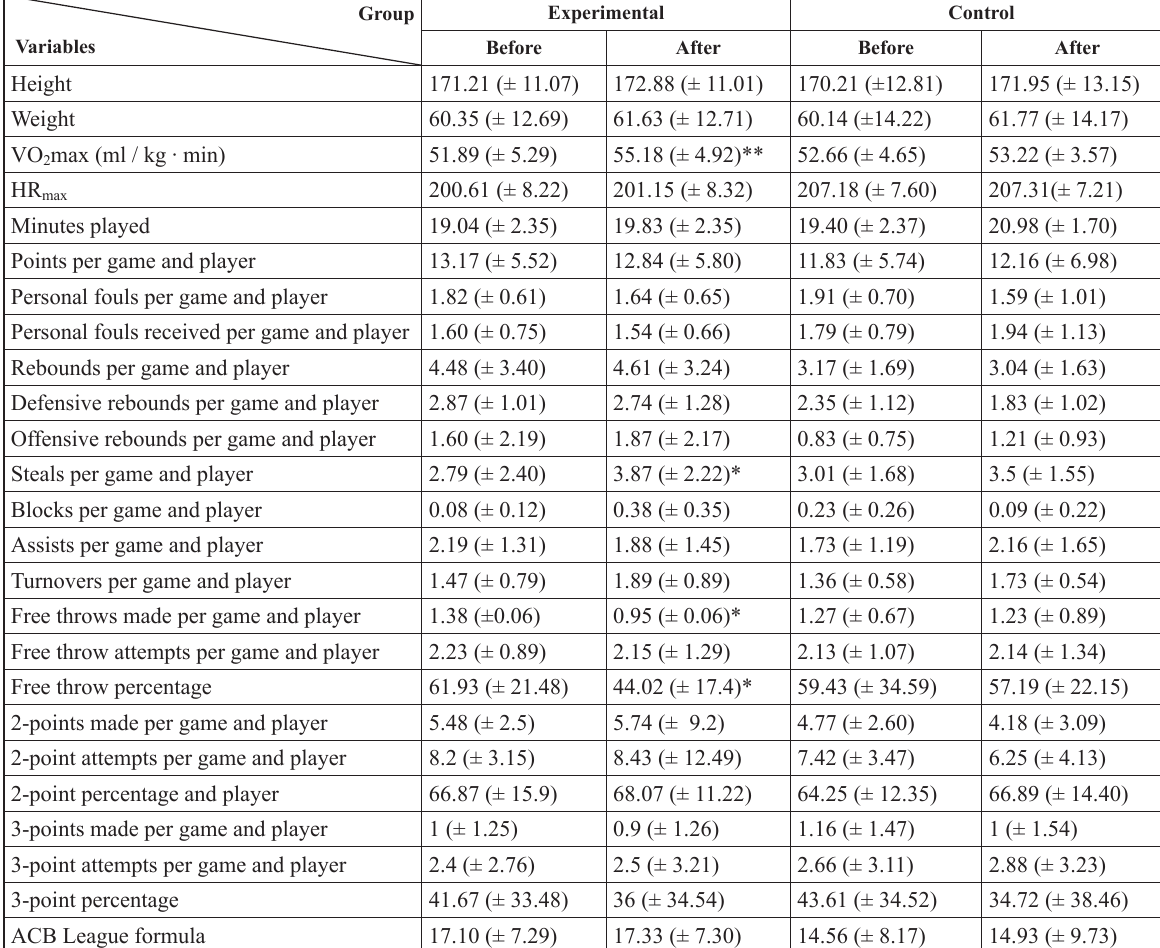
Table 3. Values of the variables studied in the experimental and control groups before and after the aerobic capacity training